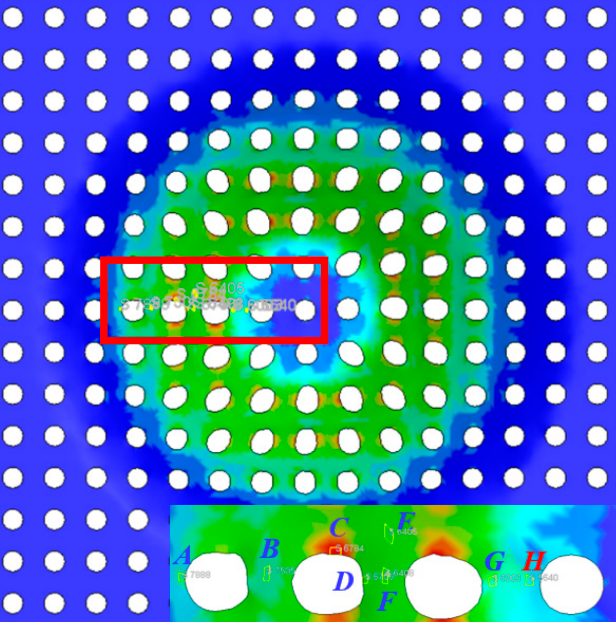
Figure 5. Schematic of sections A, B, C, D, E, F, G and H along the component wall at which the deformation history from FEA is examined.